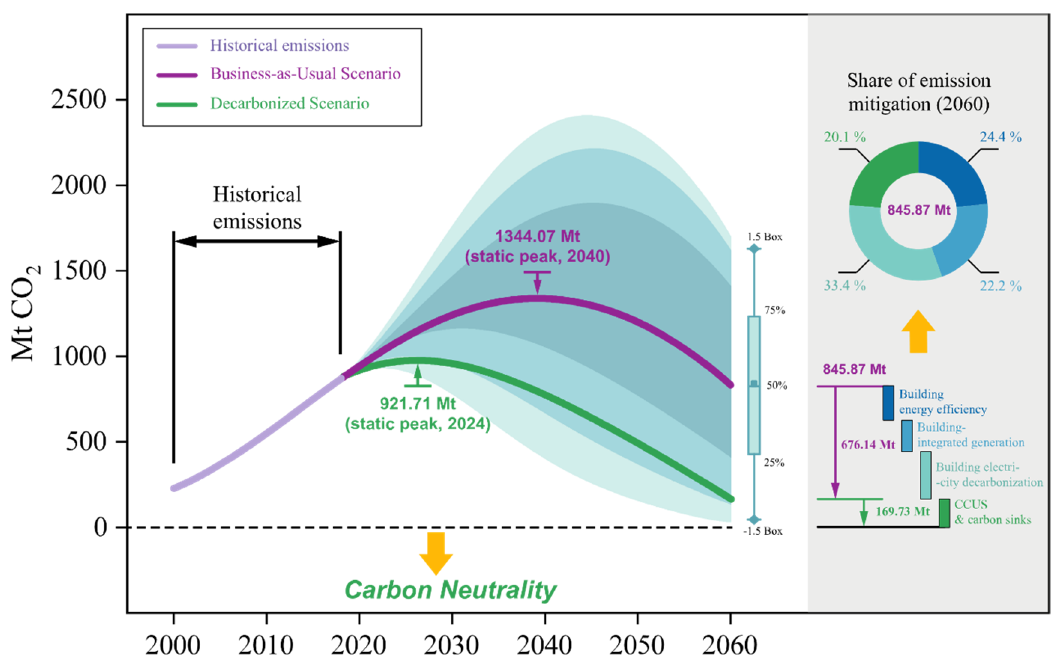
Figure 7. Decarbonization roadmap of commercial building operations to obtain carbon neutrality by 2060.